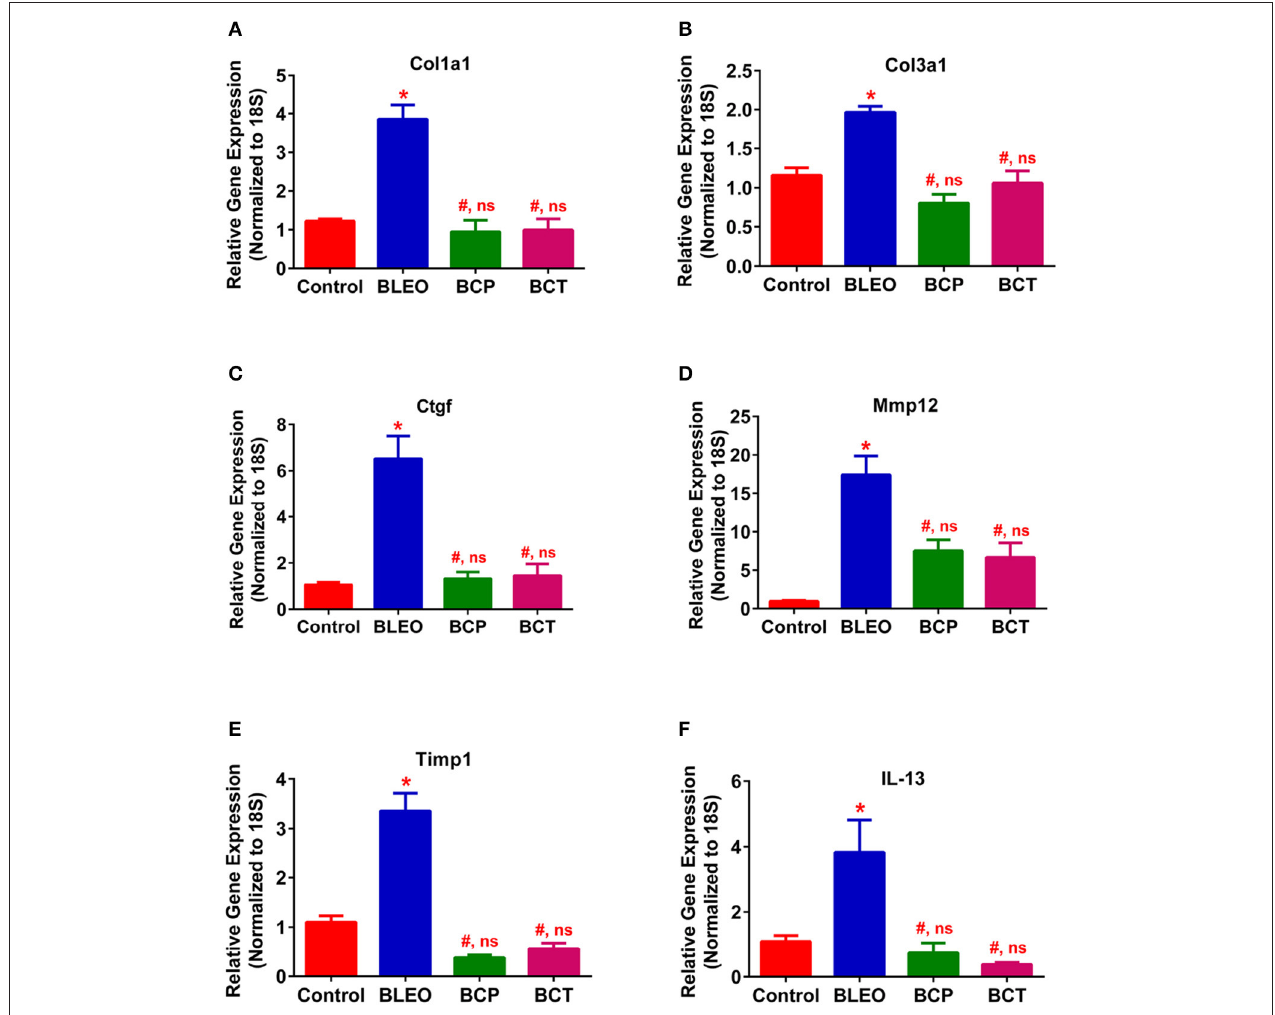
FIGURE 5 | C21 treatment attenuates the expression of markers of fibrosis and ECM in BLEO animals. (A) Col1a1, (B) Col3a1, (C) Ctgf, (D) Mmp12, (E) Timp1, and (F) IL-13. Data represented in (A–F) are mean ± SEM, n = 5 animals/group. *Indicates a p -value of ≤ 0.05, comparing BLEO animals against the controls. # Indicates a p -value of ≤ 0.05, comparing BCP and BCT vs. BLEO. ns indicates a p -value of non-significant, comparing BCP and BCT vs. control.